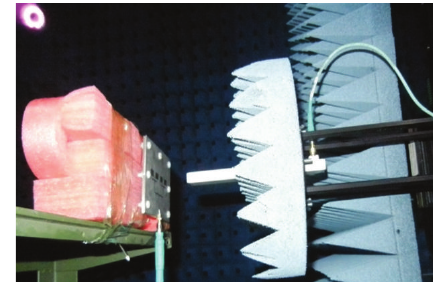
Table 3: Influence of flaw’s location on the far field pattern.